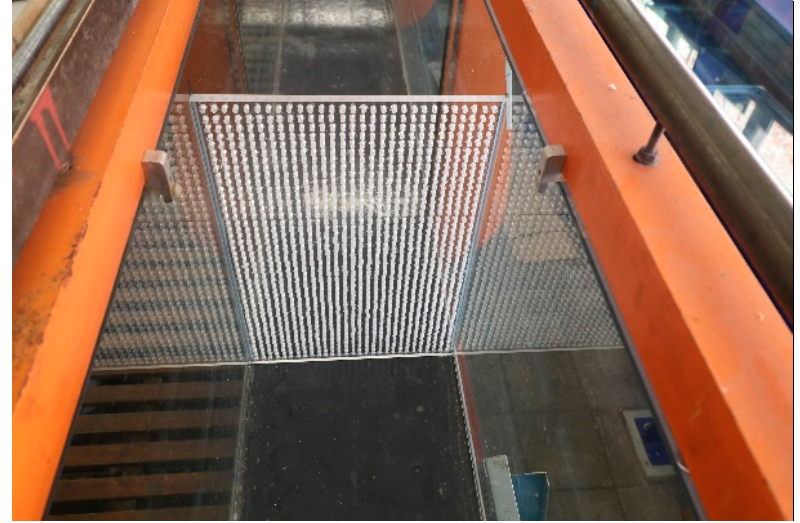
Figure 1. Picture showing model dam installed in the flume.